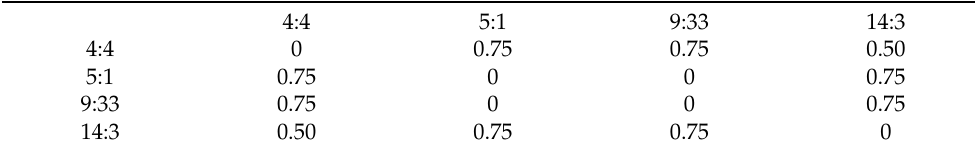
Table 4. Dissimilarity matrix of the sample dataset in Table